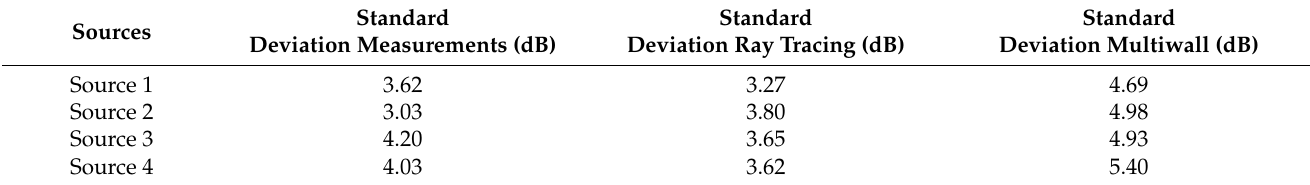
Table 3. Standard deviation calculated for different RSSI signal sources available in the building, prepared in the measurement campaign and using simulation methods (ray tracing and multi- wall methods).